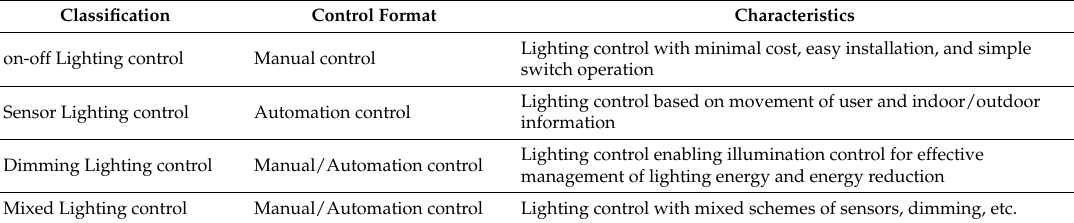
Table 1. Air cap specifications that are provided by the manufacturer.